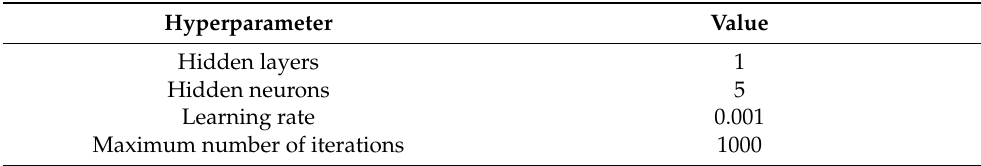
Table 1. Hyperparameter values for the MLP used in this study. Hyperparameter